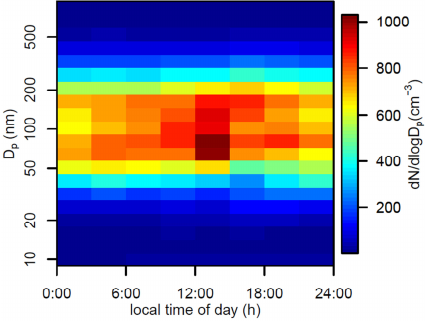
Figure 13 Diurnal cycle of number size distribution; the color code represents particle number concentrations.